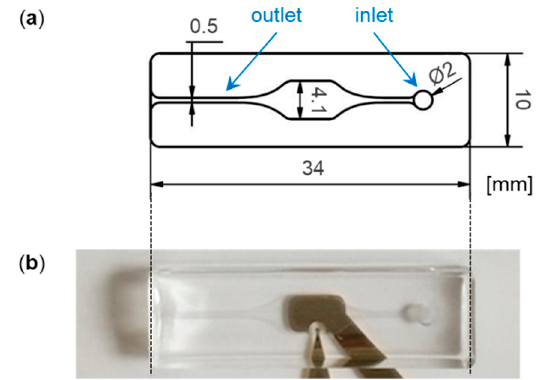
Figure 2. ( a ) Design of the microfluidic channel delivering samples across the electrodes. The channel height was 0.2 mm leading to a channel volume below 10 µL. ( b ) Microfluidic polydimethylsiloxane (PDMS) channel bonded on the impedance biosensor chip.